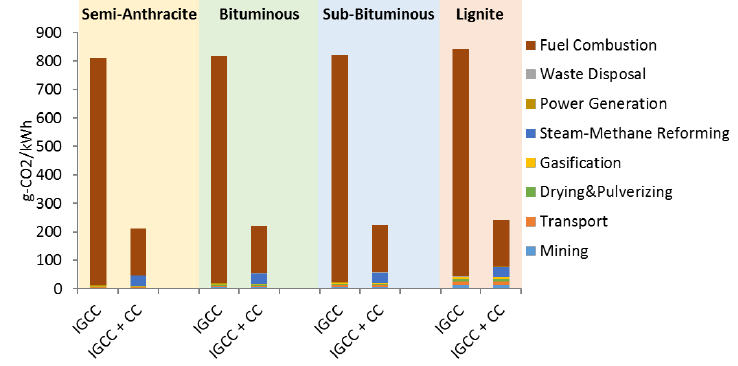
Figure 5. Life cycle carbon emissions of IGCC with and without carbon capture by input coal type. (CC denotes carbon capture).